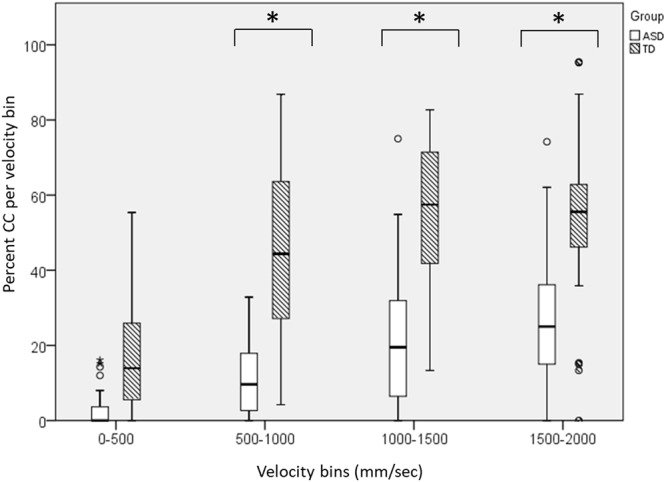
A direct comparison of the %CC segments by velocity bins, between ASD and TD participants, during the Following round. In both groups, %CC increased in higher velocities. Yet even when controlling for different game velocities, TD participants attained higher levels of CC across all velocity intervals. Large asterisks represent p < 0.05 group differences. Boxplots: the solid line represents the median of the distribution; the outlines of the box represent the interquartile range, or 25th–75th percentiles; the whiskers represent the upper and lower quartiles, excluding outliers; small points and asterisks represent outliers and extreme outliers, respectively.